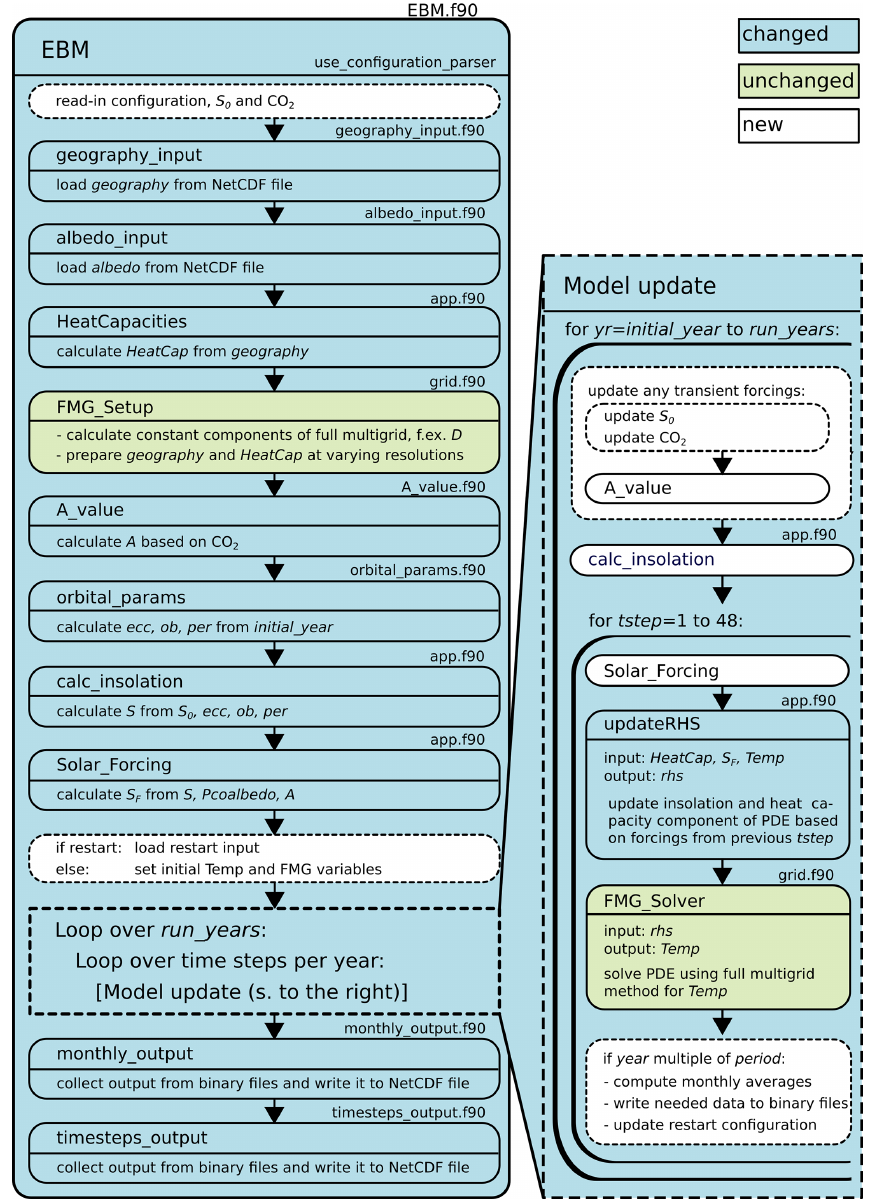
Figure 7. Main model component with new, changed, and unchanged features with respect to the EBM by Zhuang et al. (2017a) marked.